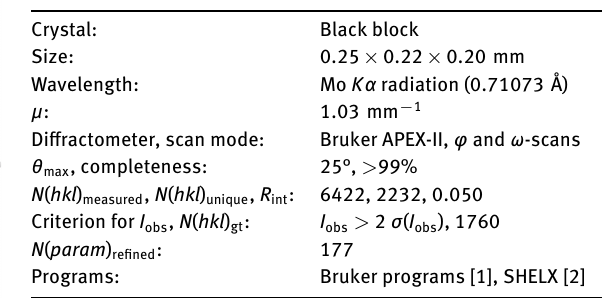
Table 2: Fractional atomic coordinates and isotropic or equivalent isotropic displacement parameters (Å 2